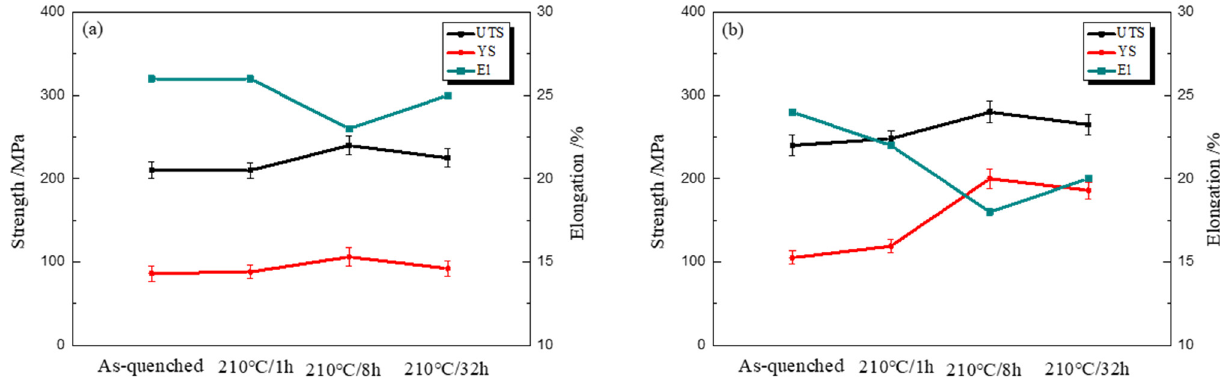
Figure 7. Mechanical properties of ( a ) Al-4Mg alloy, ( b ) Al-4Mg-0.6Ag aged for different times at 210 °C.